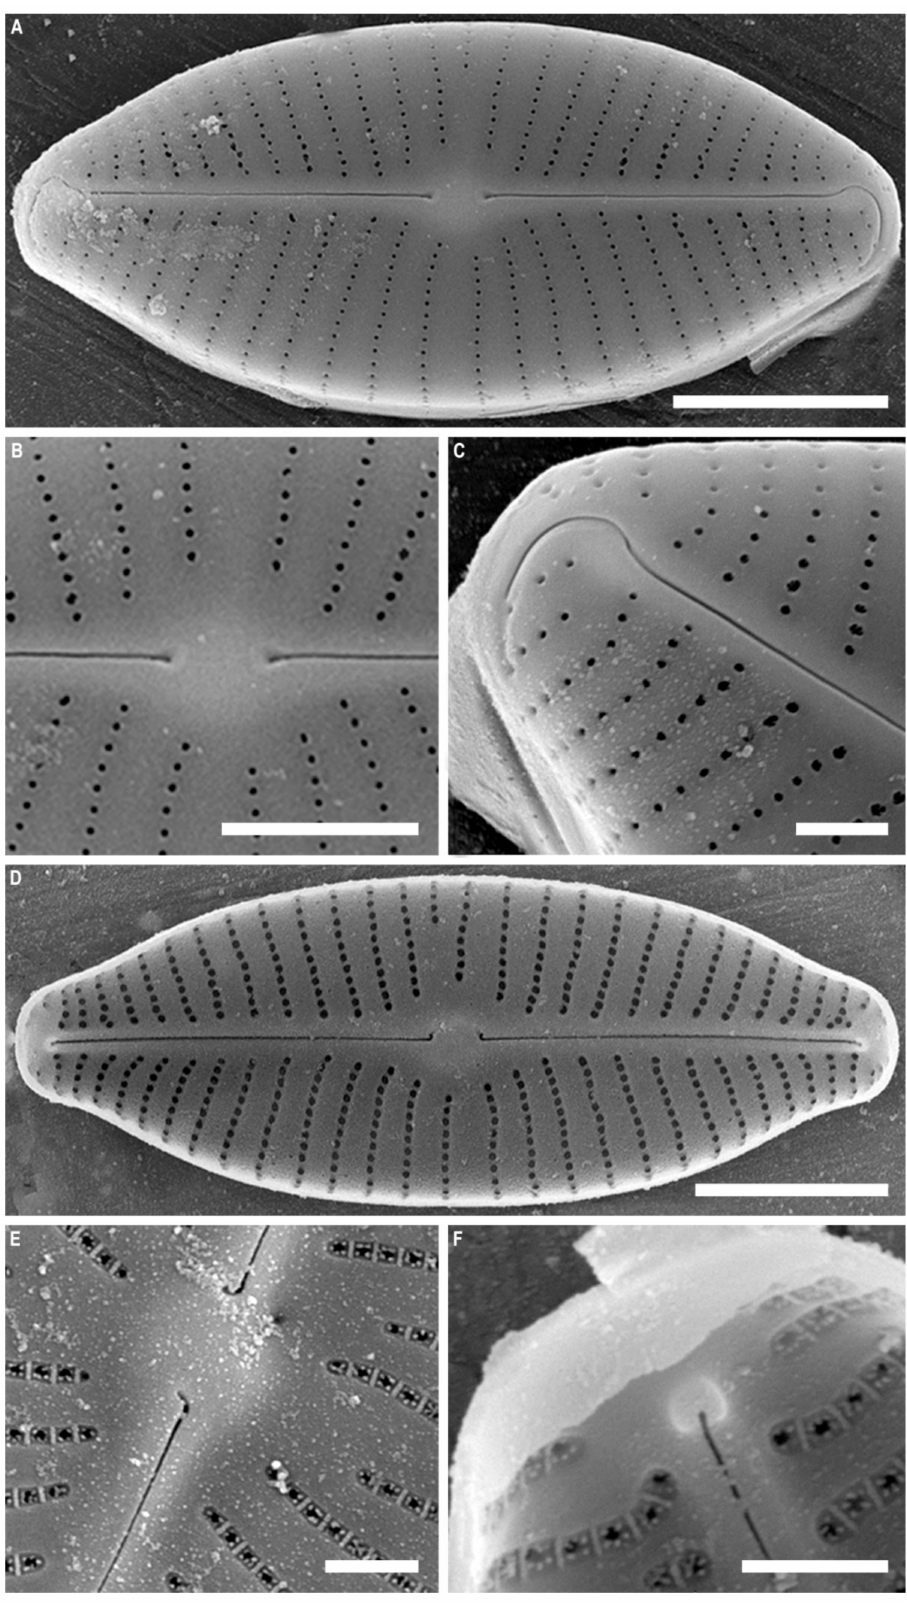
Figure 9. Placoneis neohambergii Glushchenko, Kezlya, Kulikovskiy & Kociolek sp. nov. Strain VN364, sample no. 00134. Scanning electron microscopy: ( A , D ) The whole valve. ( B , E ) Central area details. ( C , F ) Valves ends. Scale bar ( A , D ) = 5 µ m; ( B ) = 2.5 µ m; ( C , E , F ) = 1 µ